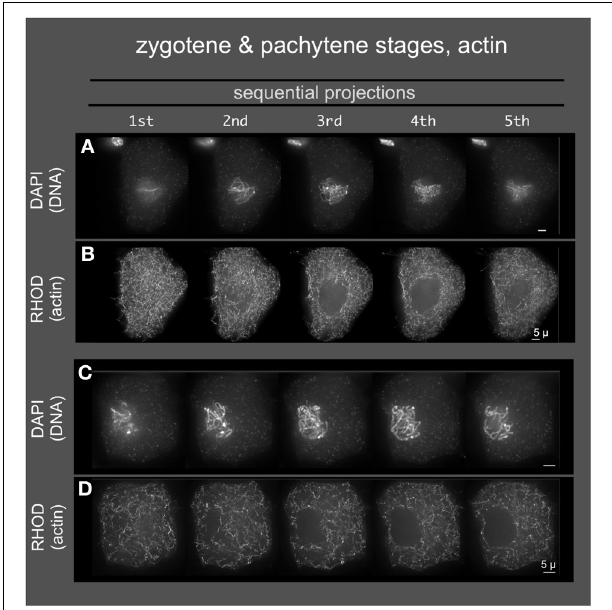
FIGURE 5 | Microfilaments in middle meiotic prophase (pachytene stage). Anthers from maize inbred line A344 were fixed and dissected meiotic cells were embedded in acrylamide gels for staining with Rhodamine Phalloidin, and counterstaining with DAPI. 3D images were collected, deconvolved, and image data was displayed as described in Figure 4 . Two cells (A,B , and C,D) are shown.